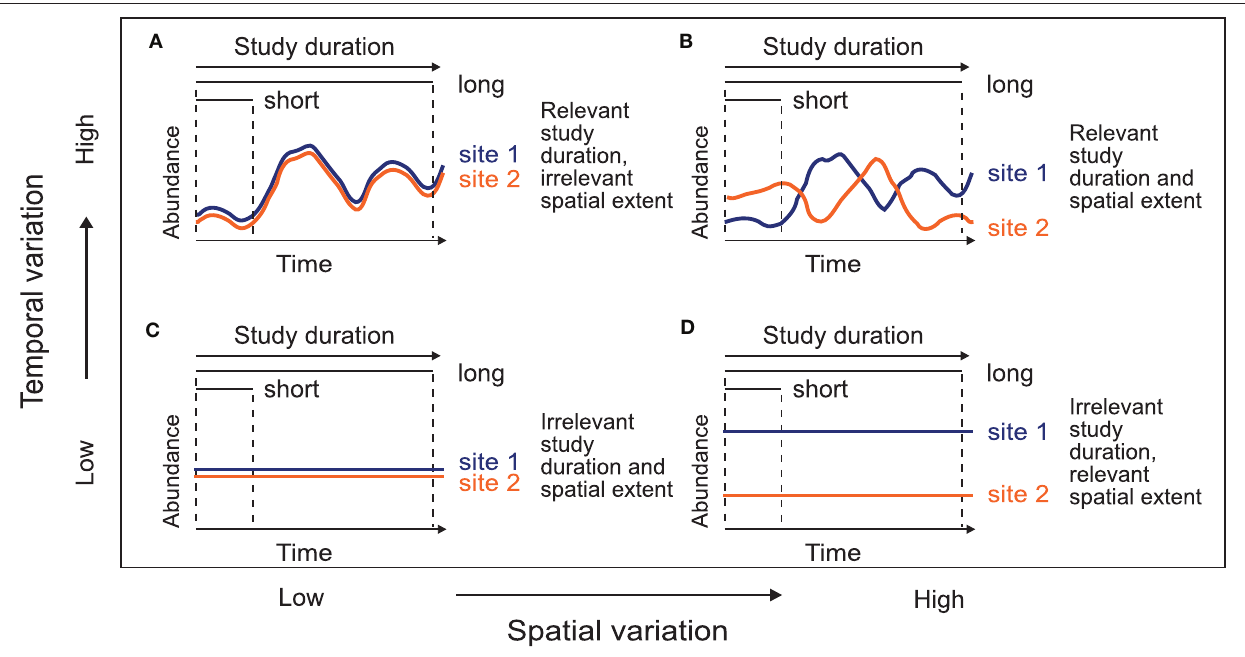
FIGURE 1 | Conceptual model of the variation distribution between the spatial and the temporal axes. Lines represent the abundance dynamics of an hypothetical species in two sites through time. When abundances temporally vary (A,B) , increasing the study duration is relevant because it allows encompassing more metacommunity variation. On the other hand, when abundances do not vary over time (C,D) , extending the temporal extent of observation (i.e., study duration) should not be relevant, because short and long-term studies show the same temporal variability. Similarly, spatial extent is important in the sampling design, depending on the spatial